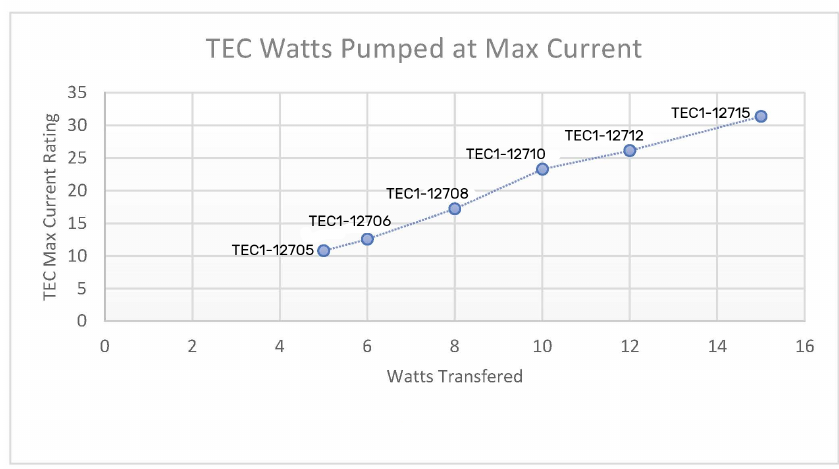
Figure 8. Plots of thermoelectric cooler (TEC) test temperatures.